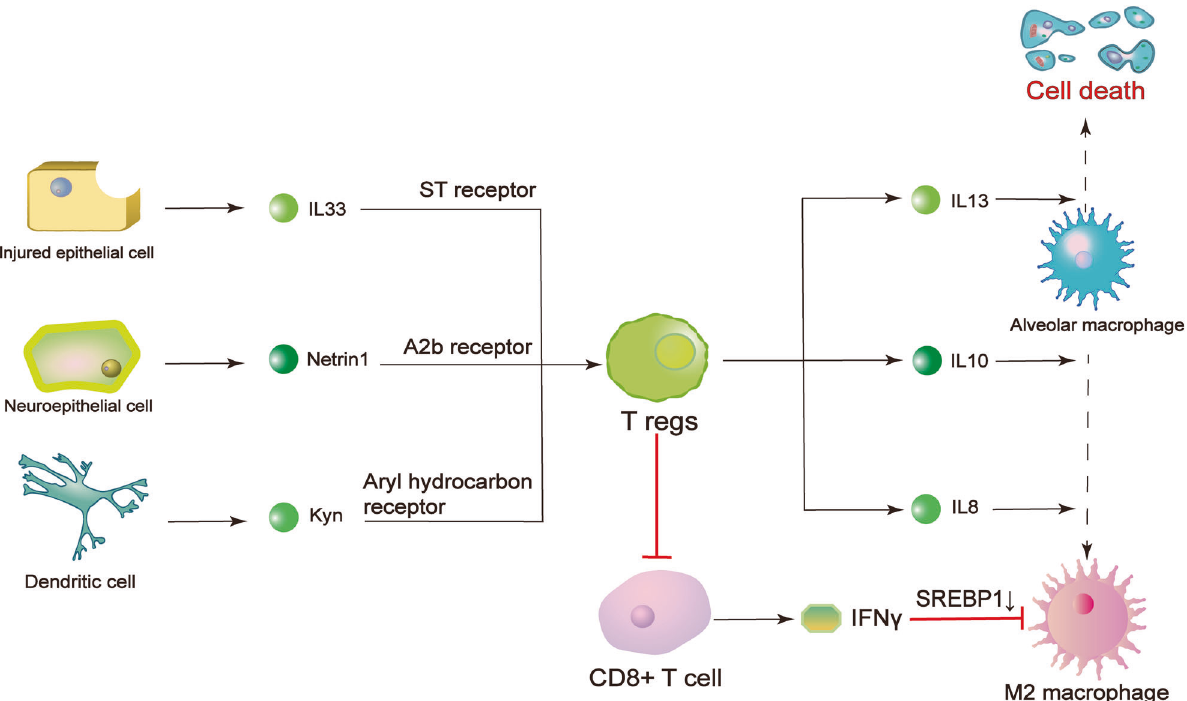
Fig. 3 Regulation of macrophage polarization by Tregs. This regulatory effect is controlled by many factors. For example, IL-33 binds to ST receptors on the Treg surface to promote IL-13 secretion, which subsequently induces apoptosis of alveolar macrophages and prevents further in fl ammation. On the other hand, netrin 1 and kynurenine both promote M2 macrophage polarization. Netrin 1 binds to A2b receptors on Tregs to induce IL-10 secretion. Kynurenine binds to AHRs and modulates transcription in Tregs, increasing the production of IL-8. Furthermore, the production of IFN γ , which inhibits M2 polarization, is inhibited by Tregs. As a result, Tregs can both prevent injury and promote tissue repair by regulating macrophage function. Kyn kynurenine, IFN γ interferon γ , IL interleukin, SREBP1 sterol regulatory element binding protein